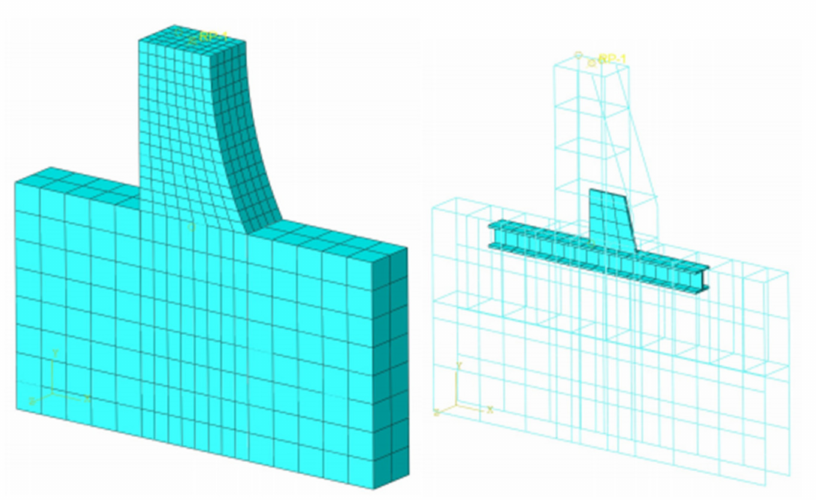
Figure 17. Finite element model of the